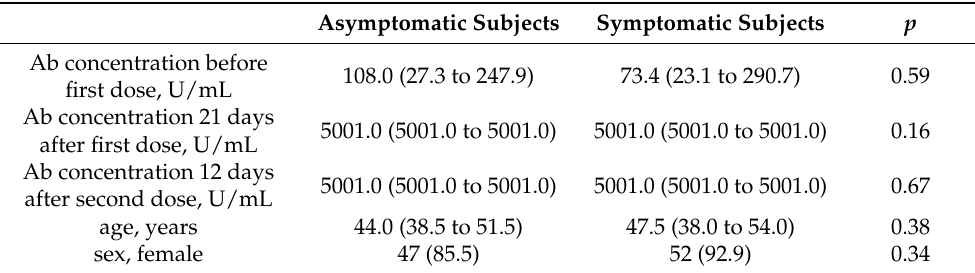
Figure 2. Logarithmic concentration of anti RBD antibodies against SARS-CoV-2 ′ s spike protein (including IgGs) before vaccination with BNT162b2, 21 days after the first dose of BNT162b2, 12 days after the second dose of BNT162b2 in symptomatic and asymptomatic subjects. Table 2. Antibody concentration before and after first and second dose of BNT162b2 in symptomatic and asymptomatic subjects.